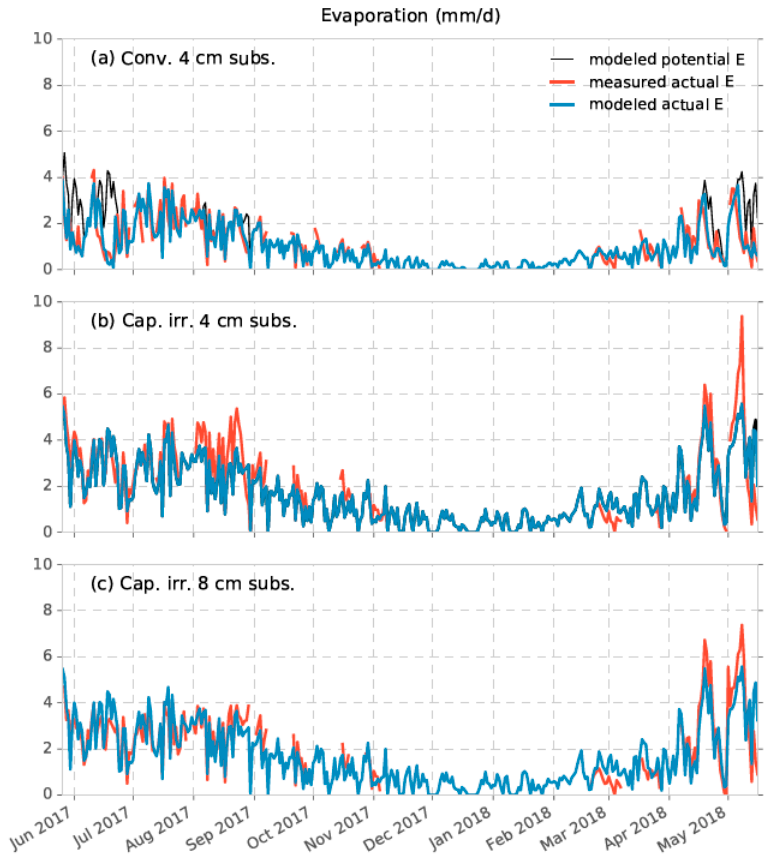
Figure 5. Measured and modeled daily evaporation for the three lysimeters. With E p calculated with on-site measured variables (black line), E a measured with weighing lysimeters (red line) and E a modeled with the simple bucket model (blue line).